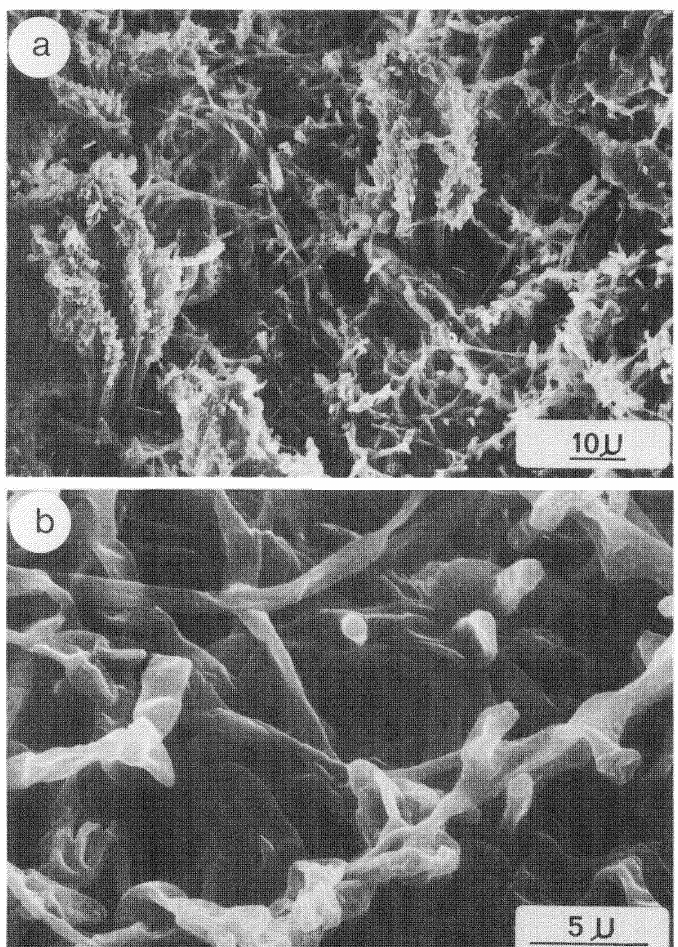
Fig. 9. Z. pallensporrasi (same individual as Fig. 8b). a. Heavily matted cephalic shield, showing tips of brush setae, b. Close-up of fibrous